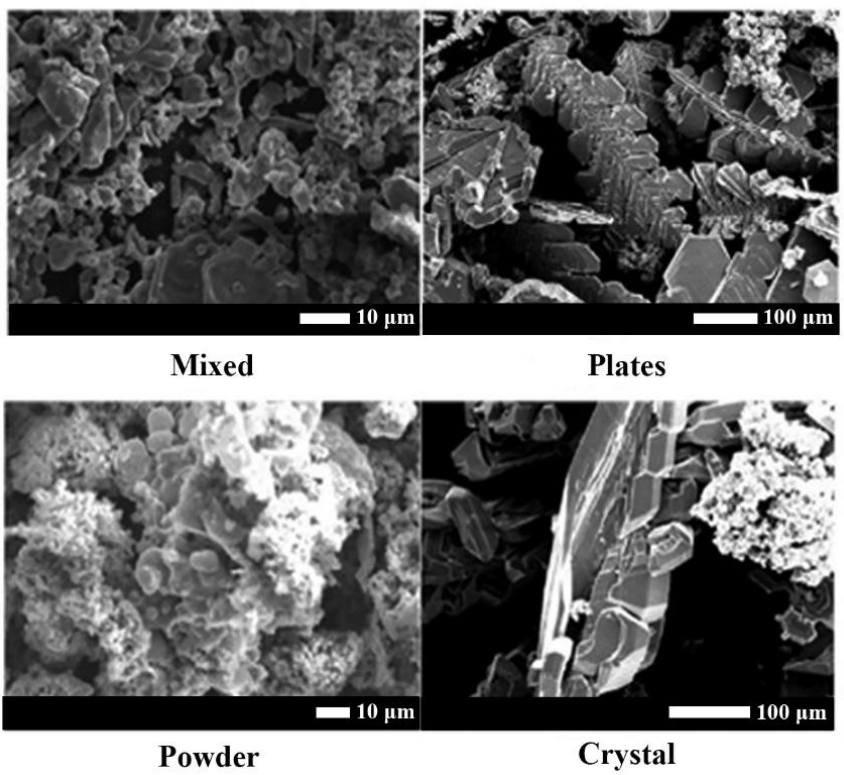
Figure 4. SEM images of different morphologies of titanium produced by CSIR-Ti process [49] (Adapted from [49], with permission from IOP Publishing, 2018).